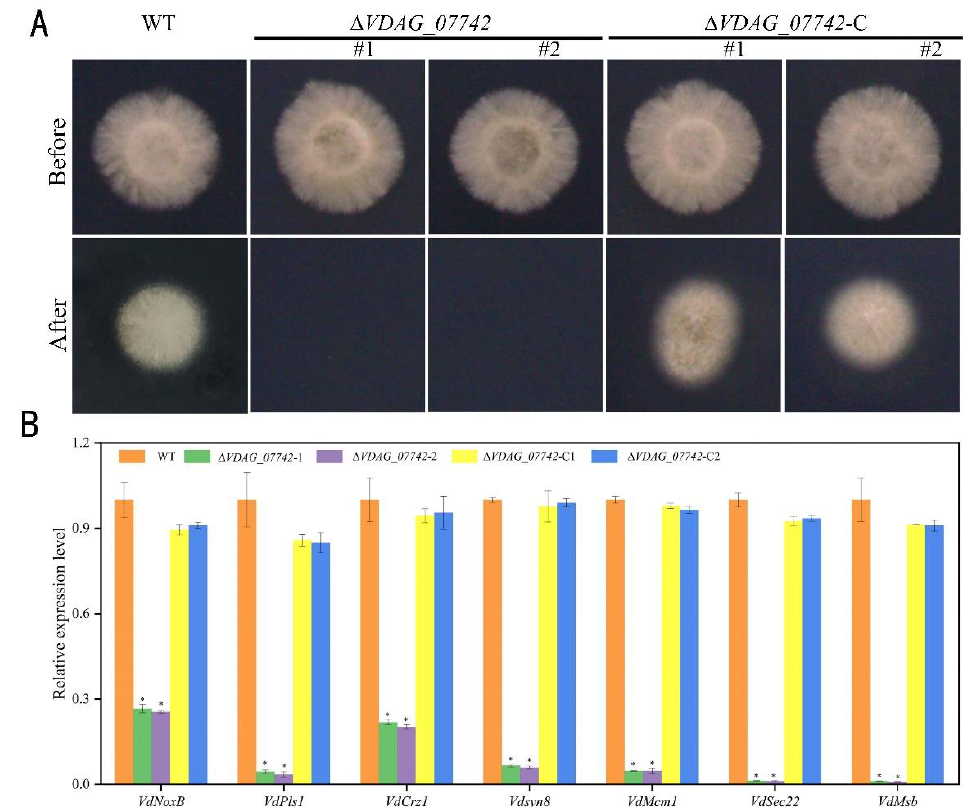
Figure 8. VDAG 07742 influences Verticillium dahliae penetration. ( A ) The first row shows the growth of wild-type (WT) V. dahliae strain JY, knockout mutants ∆VDAG_07742 -1 and ∆VDAG_07742 -2, and complementary mutants ∆VDAG_07742 -C1 and ∆VDAG_07742 -C2 cultured on cellulose membrane-covered PDA plates for 3 d; the second row shows the growth of the WT strain, knockout mutants ∆VDAG_07742 -1 and ∆VDAG_07742 -2, and complementary mutants ∆VDAG_07742 -C1 and ∆VDAG_07742 -C2 5 d following removal of the cellulose membrane; ( B ) expression of infection- related V. dahliae genes detected by qRT-PCR using β -tubulin as the reference gene. Values on the vertical axis represent the mean ± standard error (SE) of three biological replicates. Asterisks represent significant differences relative to the WT, as determined by the least significant difference (LSD) test at p =